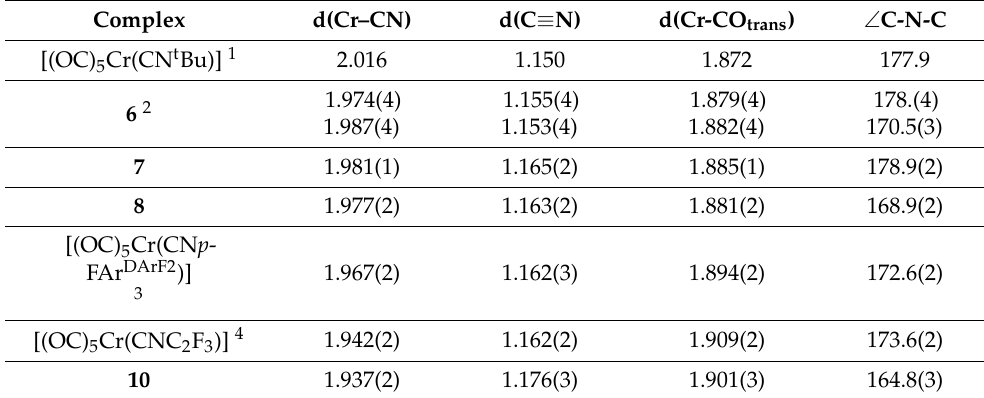
6 : Table 2; Figure 5a, Figures S4 and S5). Table 2. Selected bond distances (Å) and angles ( ◦ ) for [(OC) 5 Cr(CNR)]